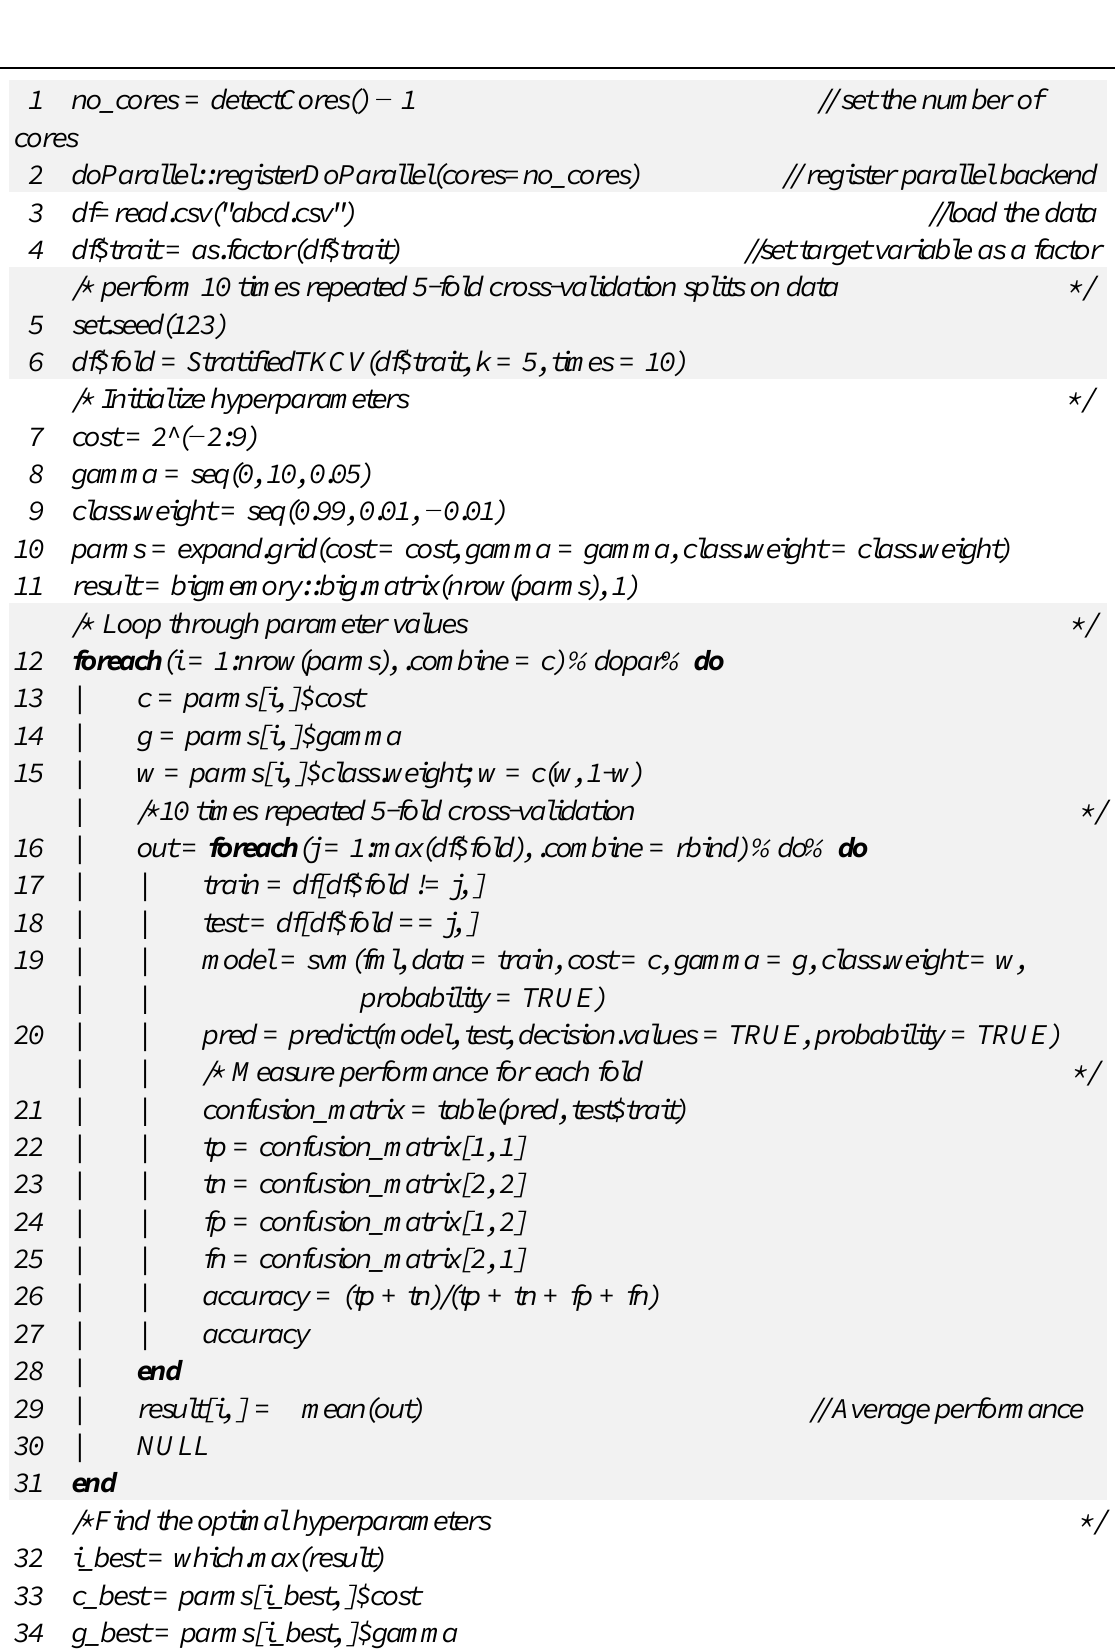
Figure 1. Pseudocode for my_script.R.